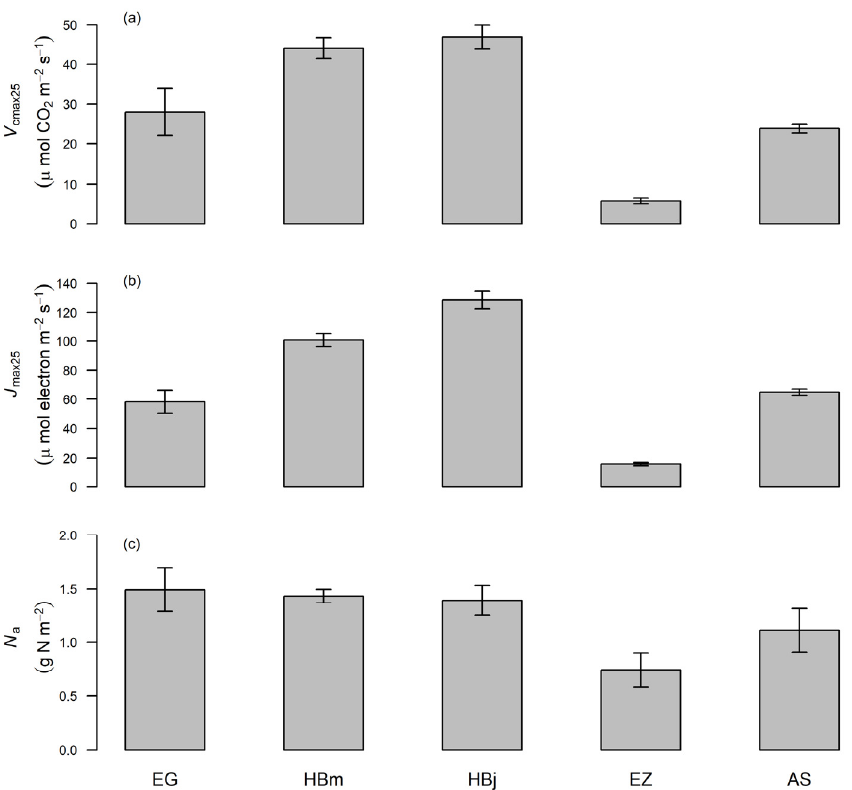
Figure 1. Mean (with standard error bars, n = 4) maximum carboxylation capacity ( V cmax25 , ( a )), maximum electron transport rate ( J max25 , ( b )) and leaf nitrogen content ( N a ) ( c ) of leaves of monoculture oil palm (EG), monoculture rubber tree (HBm), jungle rubber tree (HBj), and two native tree species (EZ and AS) measured at the lower part of the canopy. The data included mature oil palm and mature trees.